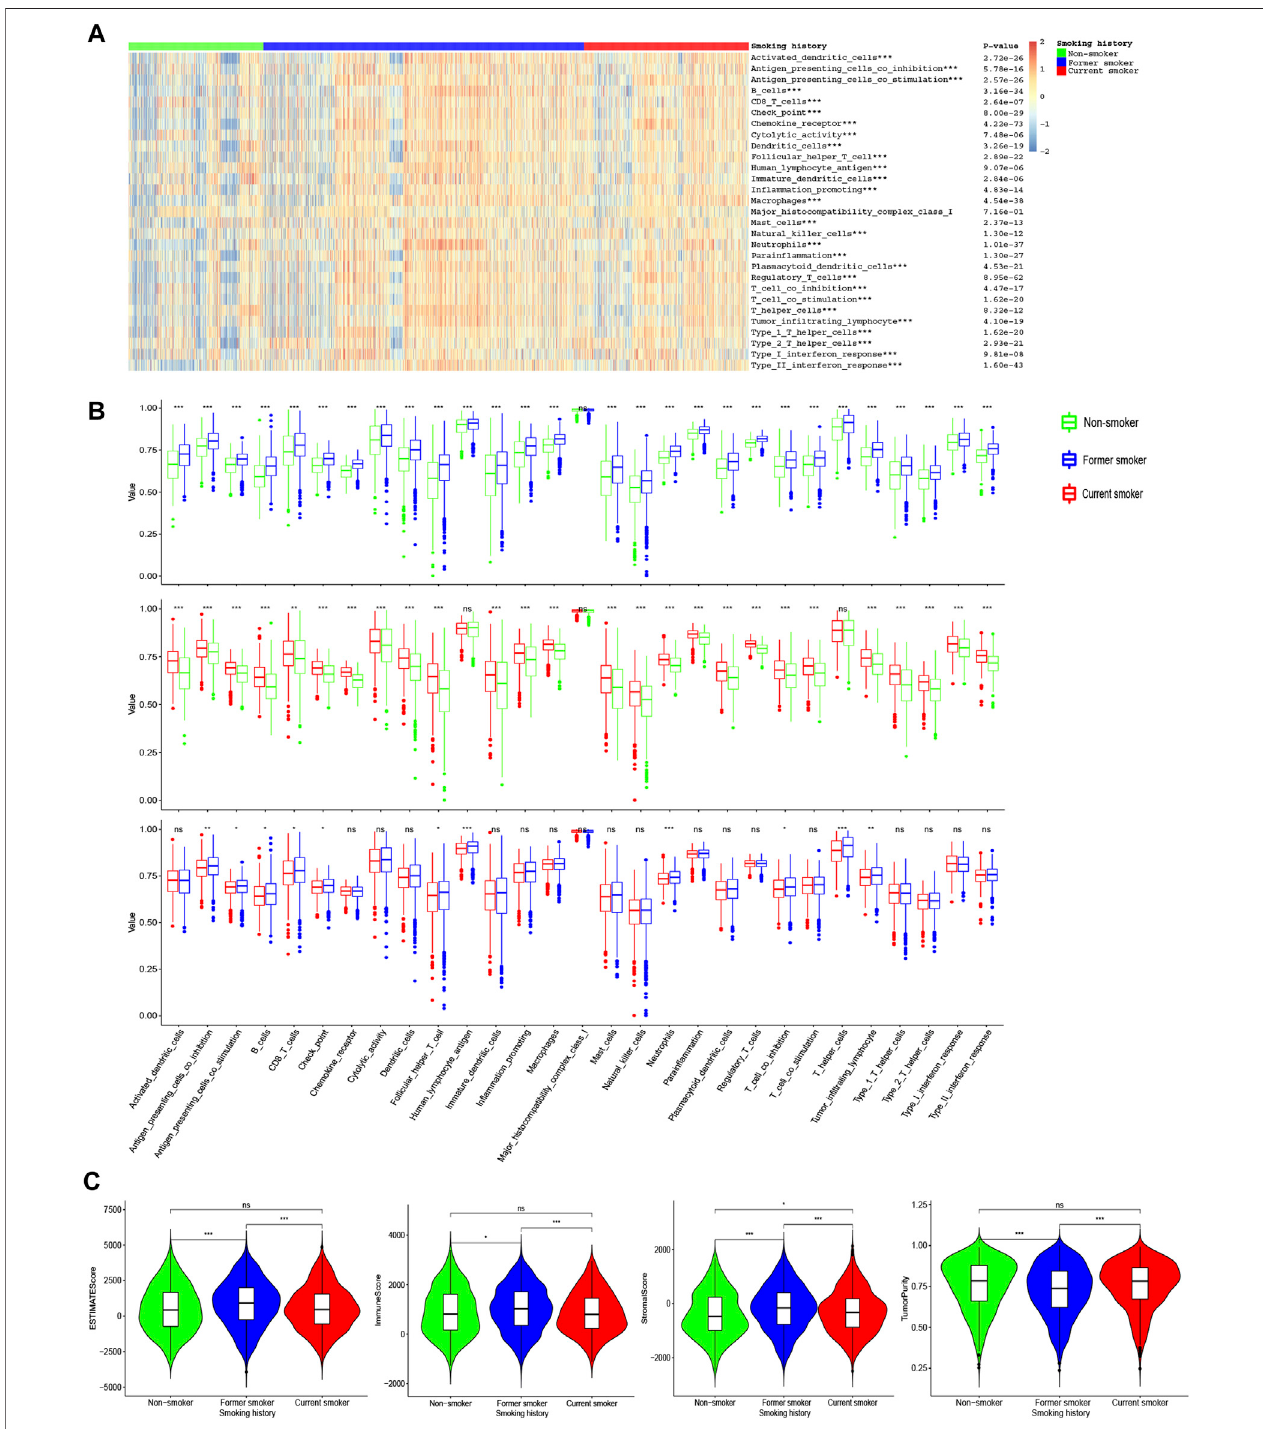
FIGURE 3 | ssGSEA of patients with different smoking histories. (A) The landscape of 29 immune indicators among patients with different smoking histories. (B) Differences in 29 immune indicators among patients with different smoking histories. (C) Differences in the stromal score, immune score, estimate score, and tumor purity among patients with different smoking